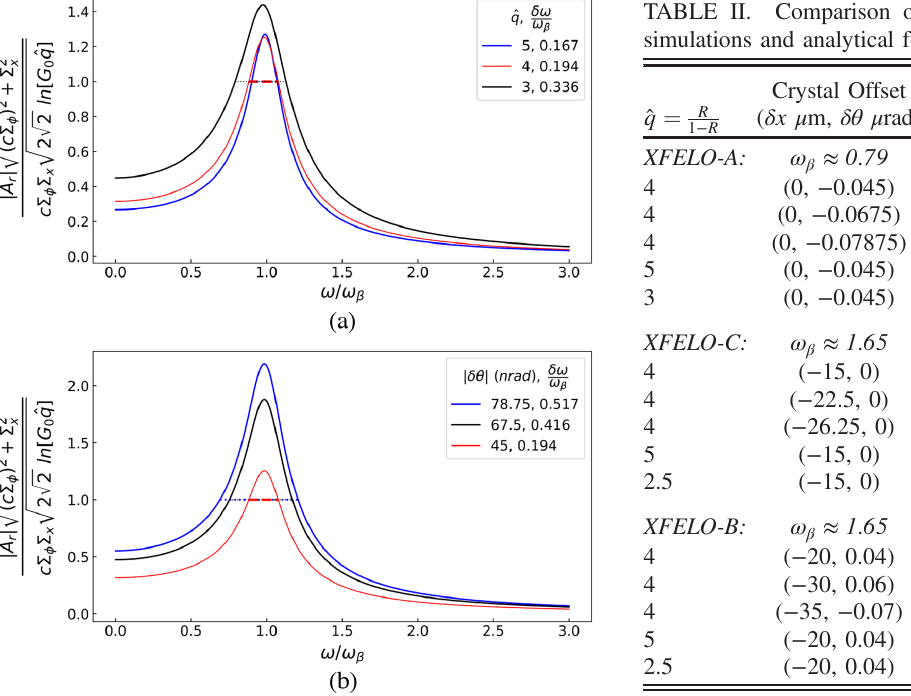
FIG. 14. Normalized excitation amplitude plotted against normalized frequency for the periodic misalignment of case studies of (a) Fig. 13 for cavities with ˆ q ¼ 3 , ˆ q ¼ 4 , and ˆ q ¼ 5 and (b) Fig. 12 in which crystal tilt of amplitude 45 nrad is amplified by a factor of 1.5 and 1.75. The resonance frequency widths are obtained when normalized excitation equals 1 based on Eq. (40), beyond which instability kicks in.